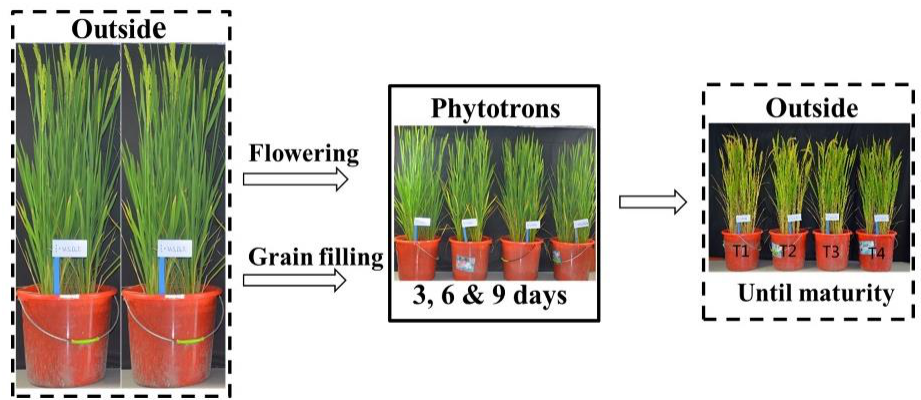
Figure 7. Pictorial view of the experiment design. T1, T2, T3 and T4 are temperature levels. The T min /T max of T1, T2, T3 and T4 were 21/27, 17/23, 13/19 and 9/15 °C, respectively.